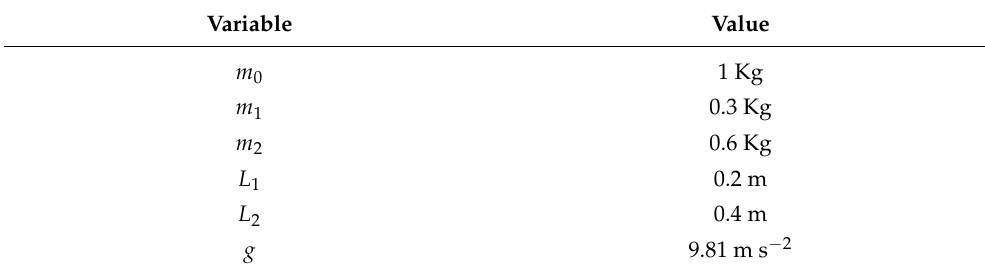
Table 1. The parameter values used for the model.